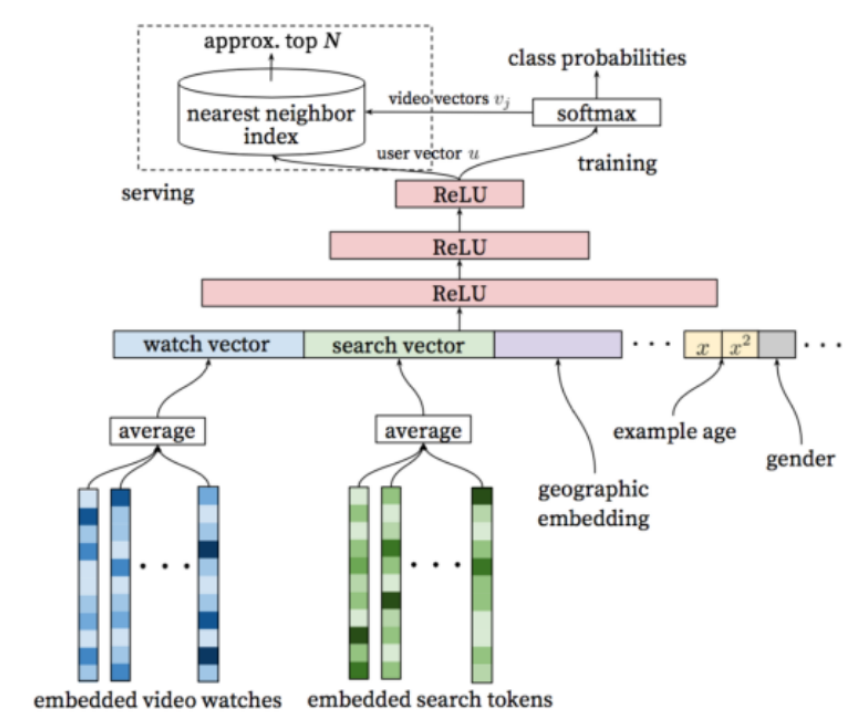
Figure 1. Frame diagram of YouTube recommendation